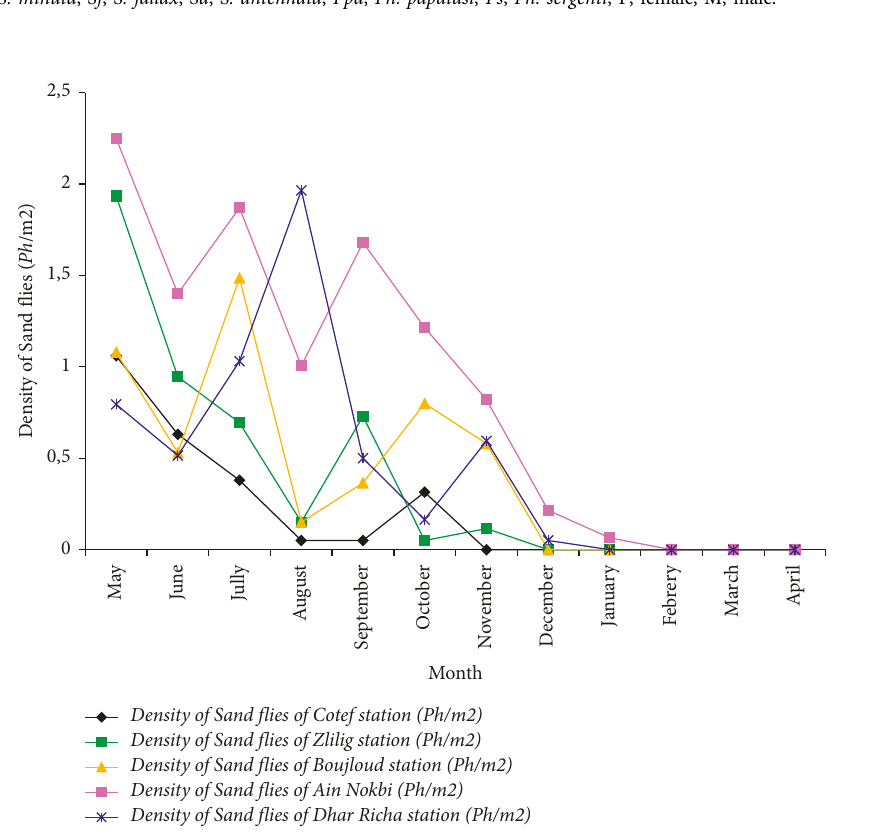
Figure 1: Seasonal activity of sand flies in different surveyed stations of the city of Fez from May 2017 to April